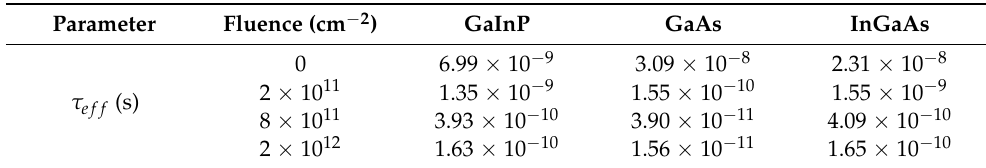
Table 2. The effective minority carrier lifetime τ ef f of GaInP, GaAs, and InGaAs subcells of IMM3J solar cells under different proton